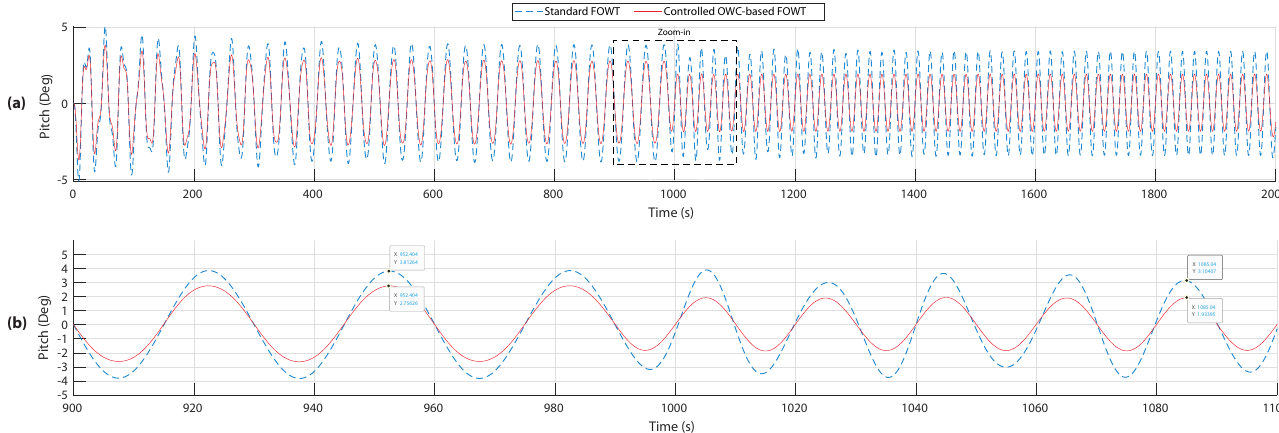
Figure 9. Obtained platform pitch in both structures. ( a ) Platform pitches. ( b ) Zoom-in of the platform pitches. The obtained tower top fore-aft displacement of the OWC-based FOWT has been compared to the one of a standard barge-based FOWT and are both illustrated in Figure 10.